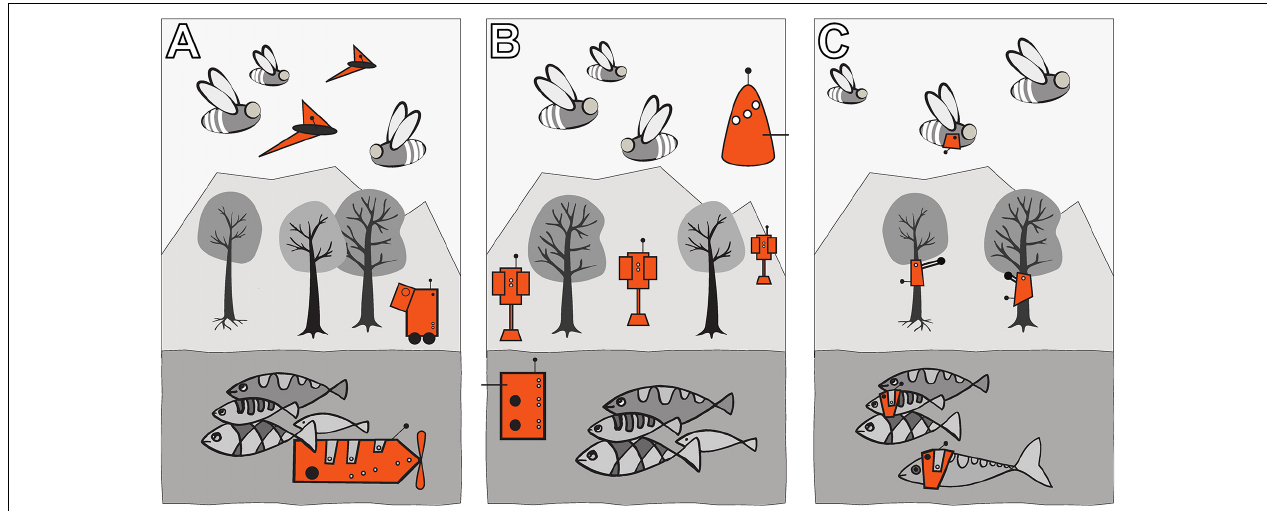
FIGURE 3 | Augmentation of organismic populations may be implemented in three main forms (Mondada et al., 2013). (A) By introducing mobile devices into the ecosystem. These agents are able to interact with the natural organisms using specifically designed stimuli. (B) By adding fixed devices in the environment. These devices exhibit agency and can create environmental conditions that have an impact on the ecosystem and specifically on the organisms that are addressed with the system. (C) By mounting devices directly on the individuals and impacting their behaviour by an interaction that takes place directly on their body. This way, the animals become biohybrid agents